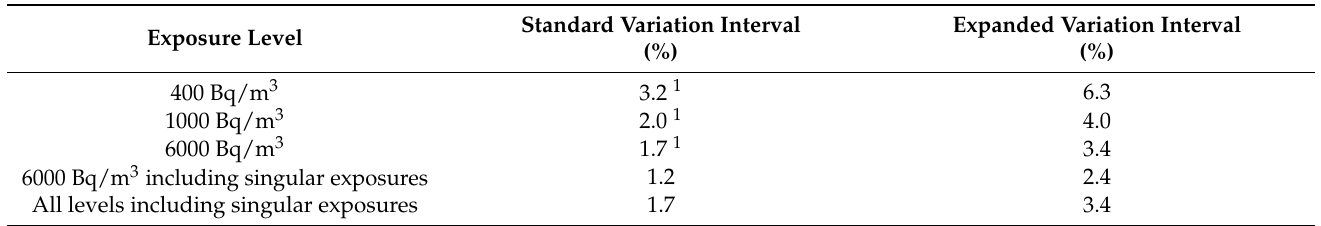
1 Indicated by blue dashed lines in Figure 2.